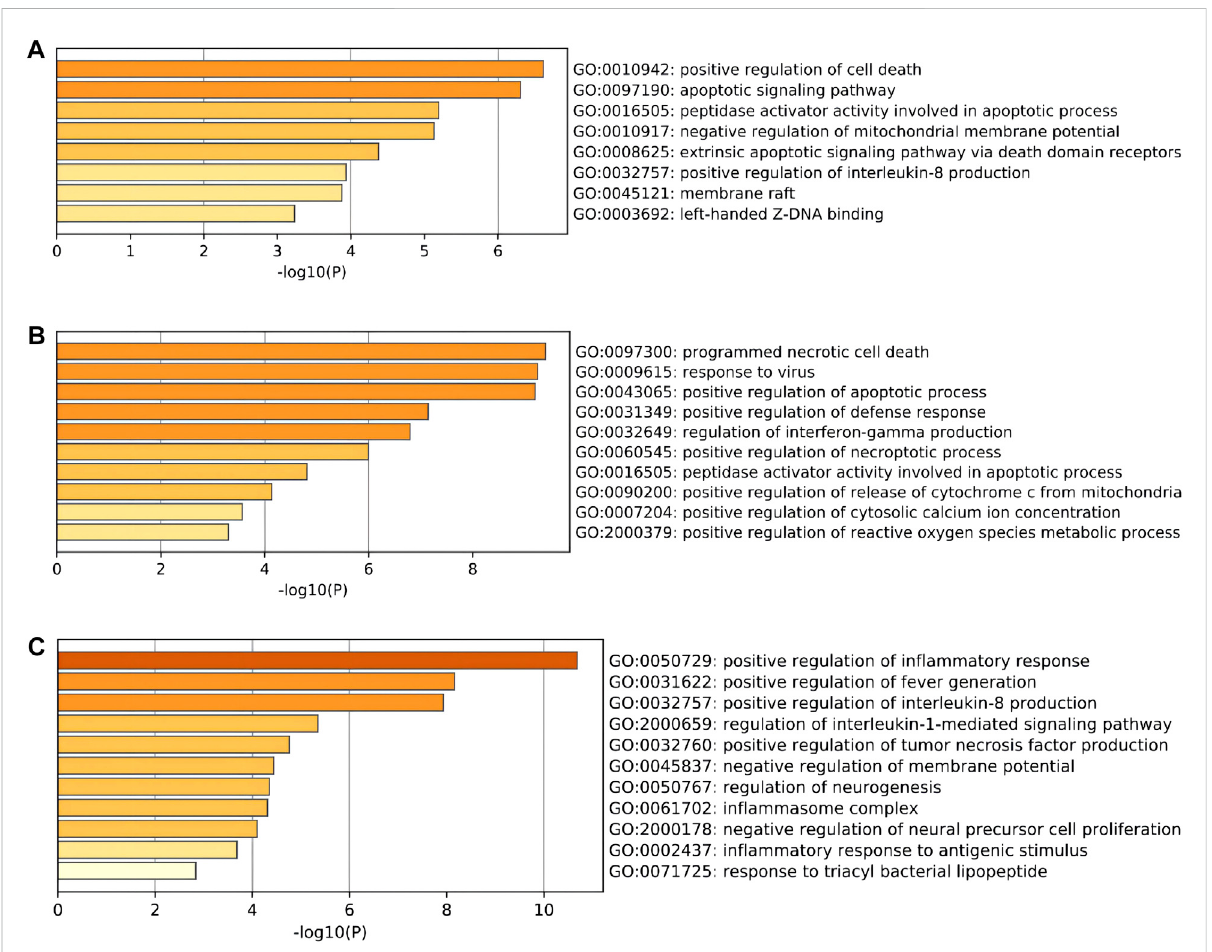
FIGURE 3 Gene Ontology (GO) enrichment analysis of these differentially expressed programmed cell death (PCD)-related genes. (A) Signi fi cantly enriched GO terms of differentially expressed apoptosis-related genes (DEARGs). (B) Signi fi cantly enriched GO terms of differentially expressed necroptosis-related genes (DENRGs). (C) Signi fi cantly enriched GO terms of differentially expressed pyroptosis-related genes